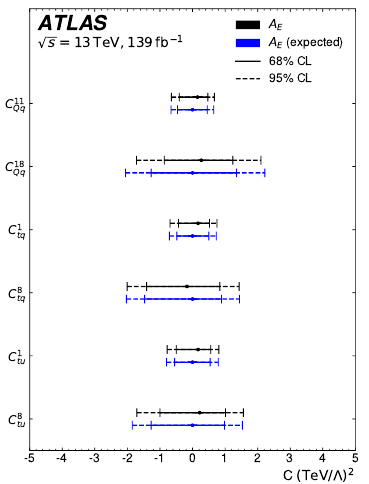
Figure 29. Bounds at 68% CL (solid) and 95% CL (dashed) on individual four-quark Wilson coefficient from the ATLAS energy asymmetry, from a combined fit to the measured (black) and expected (blue) energy asymmetry in three jet-angle bins